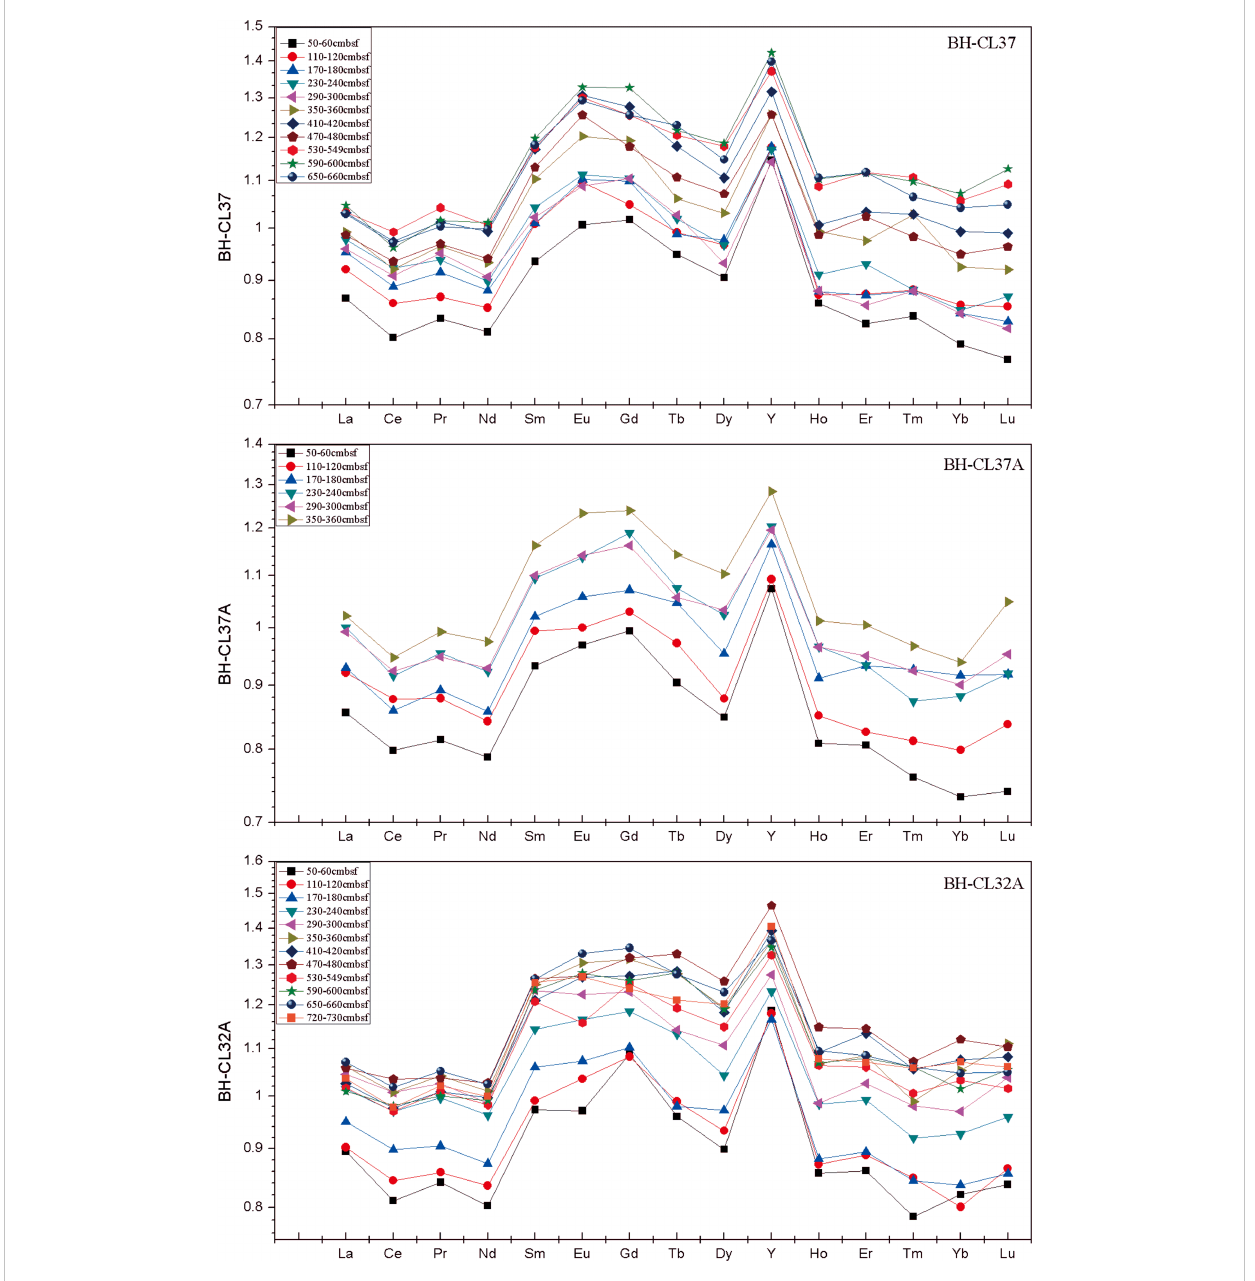
FIGURE 9 REE+Y distribution curves of BH-CL37, BH-CL37A and BH-CL32A at different depths. They are characterized as enrichment of middle rare earth element (MREE) and Y without Ce and Eu